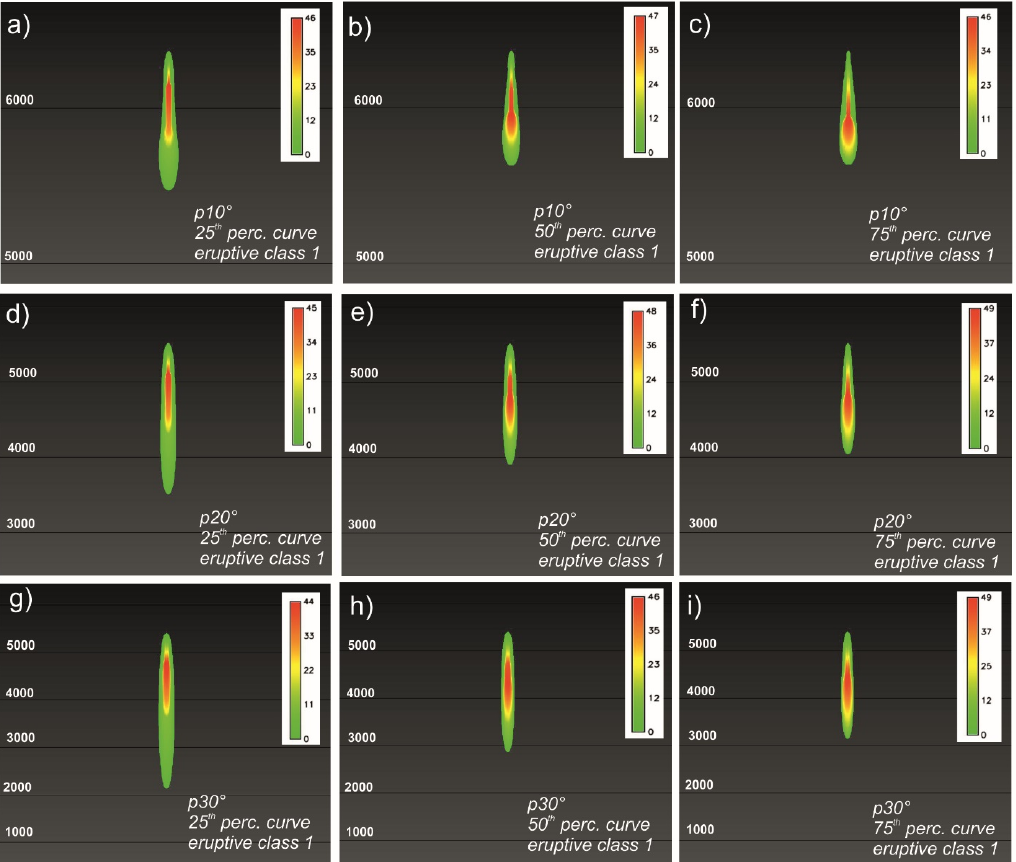
Figure 7. Results of the simulations showing the lava emplacement on inclined planes with slopes of 10° ( a – c ), 20° ( d – f ) and 30° ( g – i ), originating from 25th, 50th and 75th percentiles curves associated to the eruptive class 1 (i.e., 30 × 10 6 m 3 of lava erupted in 30 days). The thin lines represent the level curves associated with the inclined planes. The color bars indicate the thickness in meters of the simulated lava flows.